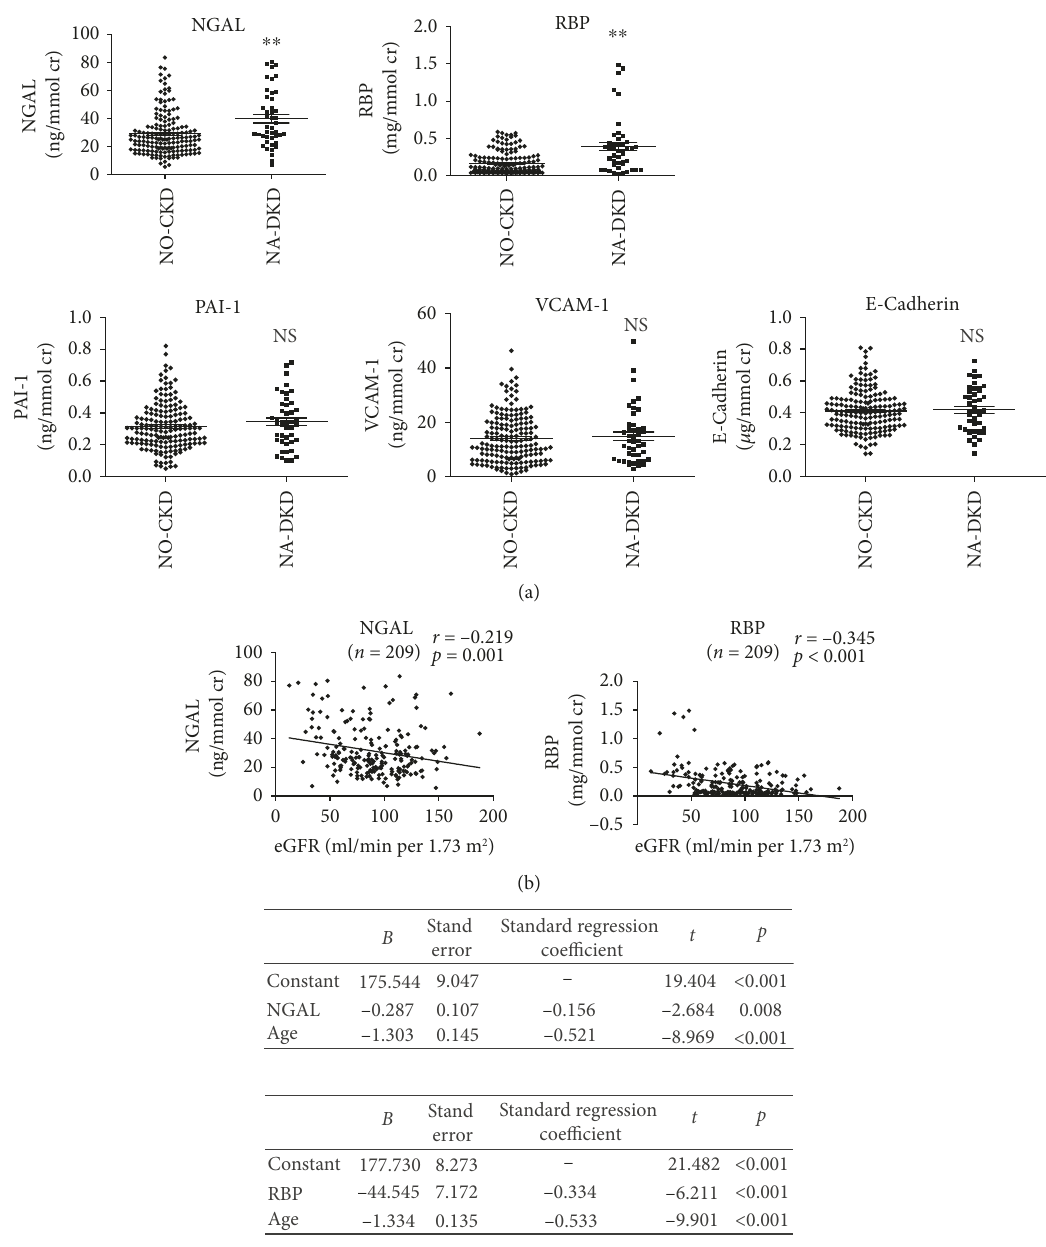
Figure 2: Correlations between urinary NGAL, RBP, PAI-1, VCAM-1, and E-cadherin with eGFR in T2DM patients with normoalbuminuria. (a) Levels of urinary NGAL, RBP, PAI-1, VCAM-1, and E-cadherin in patients with normoalbuminuria with/without renal insu ffi ciency. (b) Single linear regression analysis of urinary NGAL, RBP, and eGFR in T2DM patients with normoalbuminuria. (c) Multiple linear regression analysis of urinary NGAL or RBP, clinical parameters, and eGFR. NGAL: neutrophil gelatinase-associated lipocalin; RBP: retinol-binding protein; PAI-1: plasminogen activator inhibitor-1; VCAM-1: vascular cell adhesion molecule-1. ∗∗ p < 0 01 vs. NO-CKD group. NS: no signi fi